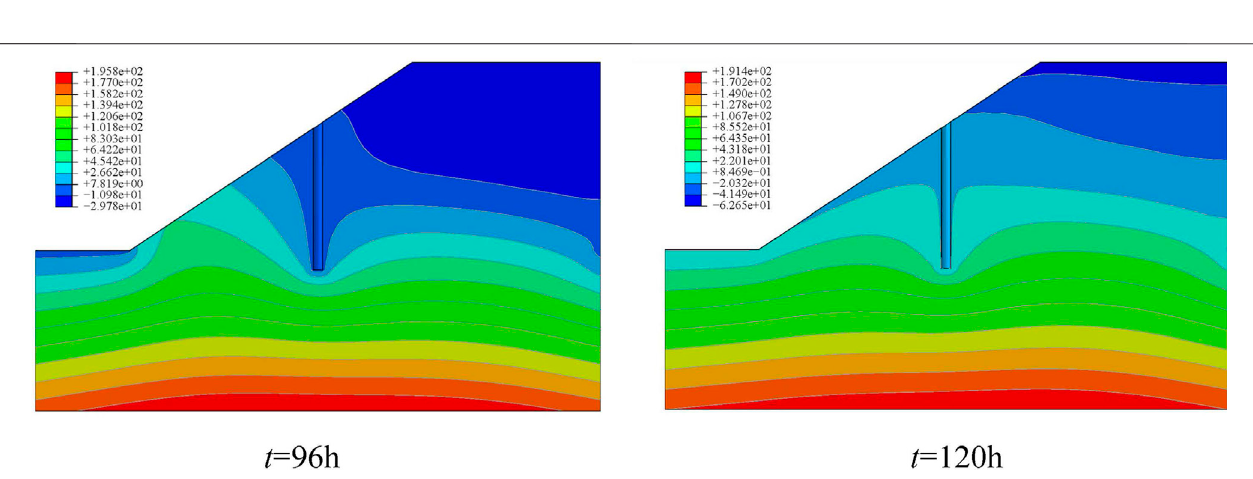
FIGURE 7 | Distribution of pore water pressure of the slope at different times in the form of a single peak.